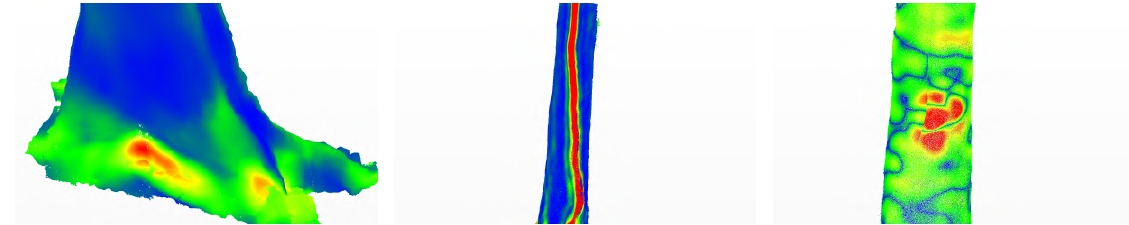
Figure 4. Visual comparison of Lichen presence in point clouds (left) Photogrammetry, (right) Azure Kinect